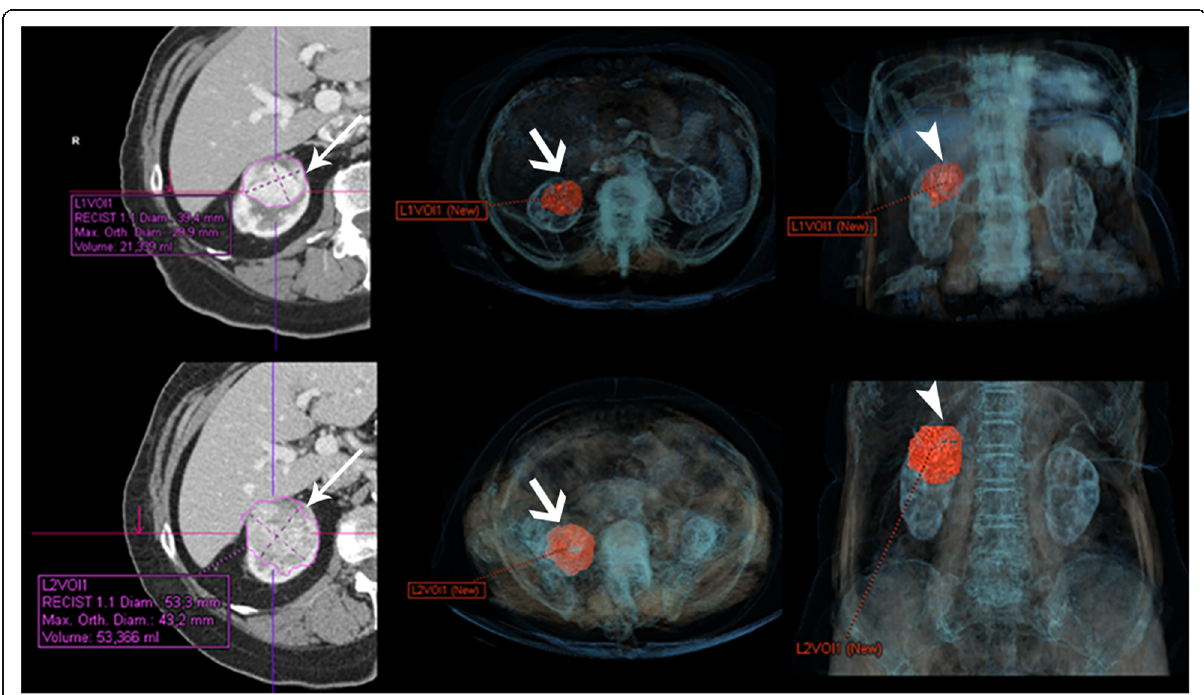
Fig. 12 Comparison between linear and volumetric measurements of small renal mass (SRM) growth over a 6-month period. Upper- and bottom- left: axial contrast-enhanced CT showing a renal mass with MTD 3.9 cm at the beginning of AS and 5.3 cm in the next study 6 months later with a linear GR of 1.4 mm between the two studies corresponding to a linear GR of 3.8 cm/year (arrows). Volumetric representation of the renal mass in an axial plane (thick arrows) (upper- and bottom-middle) and coronal plane (arrowheads) (upper- and bottom-right). The software showed an initial volume of 21 cc and a final volume of 53 cc. The increase in volume was 32 cc, indicating that the mass had doubled in volume over a 6- month period representing a rapid growth, although there are no established volume values to define progression